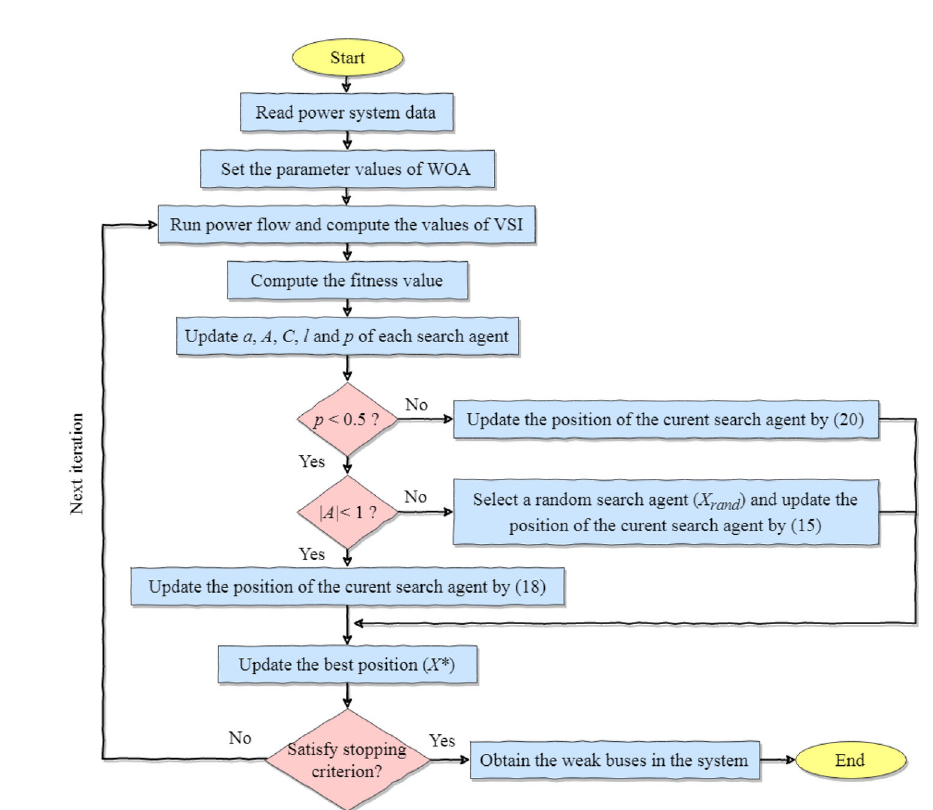
Fig. 6 General procedure of WOA-based weak buses identification